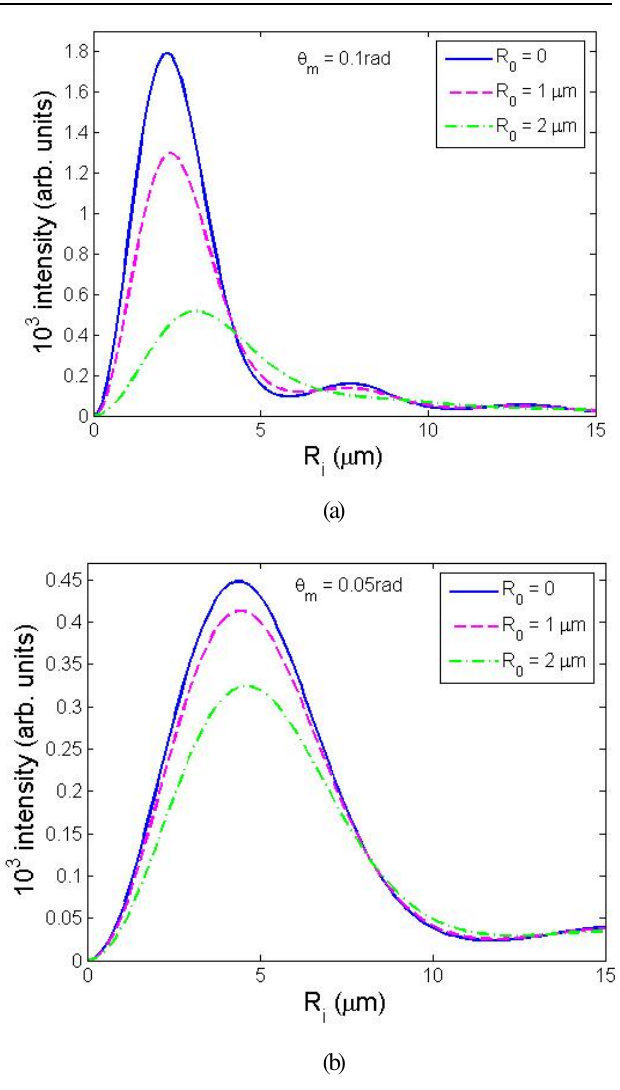
FIG. 3. (Color) PSF of the ODR generated from small radius circular aperture for various acceptance angles. (a) (cid:6) (cid:3) 0 : 05 rad . The parameters used are (cid:3) (cid:3) 0 : 1 rad ; (b) (cid:6) m 10 000 , (cid:4) (cid:3) 0 : 5 (cid:8) m , and M (cid:3) 1